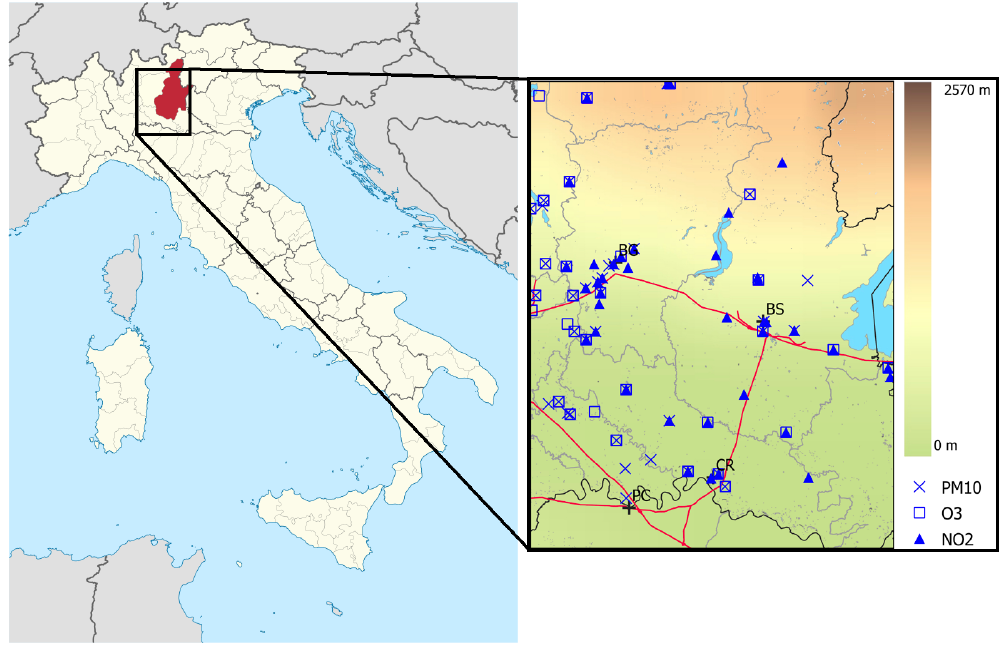
Figure 2. Modelling domain including the location of monitoring network